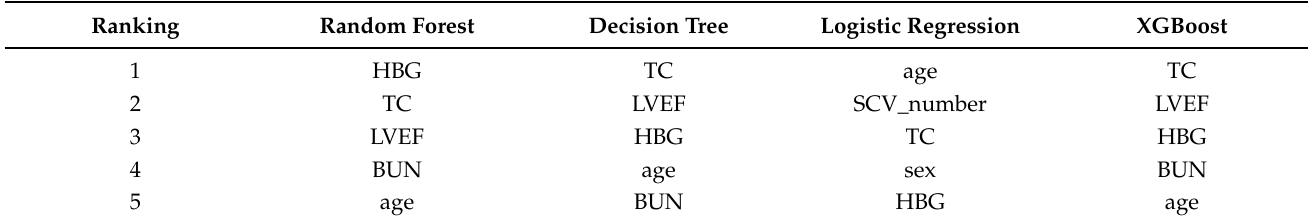
Table 5. Features ranking of 4